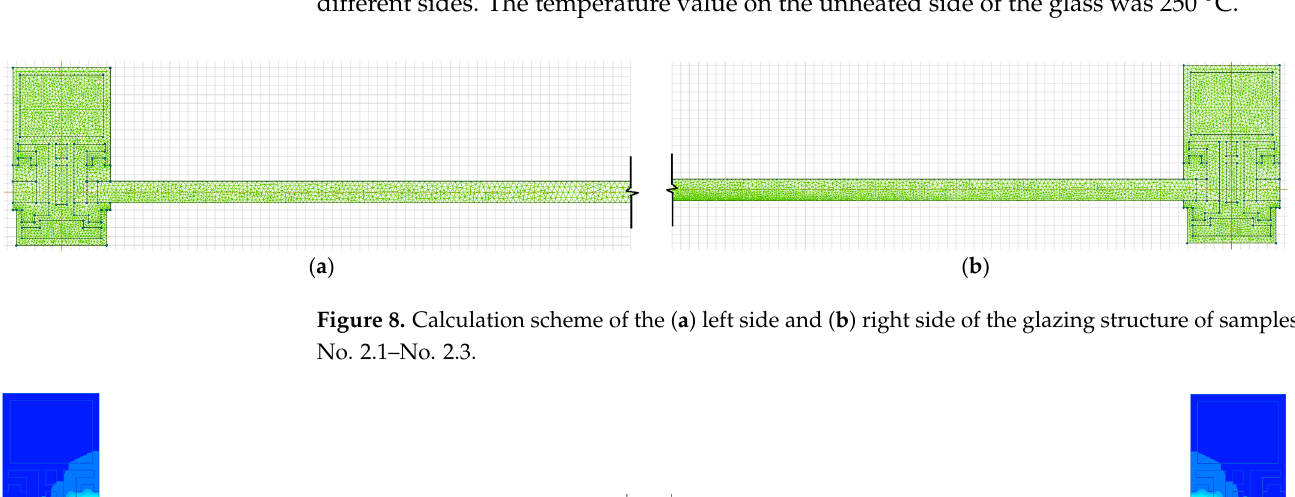
Figure 7. Large-sized sample No. 3.1 during the fire impact at ( a ) 48 min, ( b ) 57 min, and ( c ) 60 min. Photo by the authors.